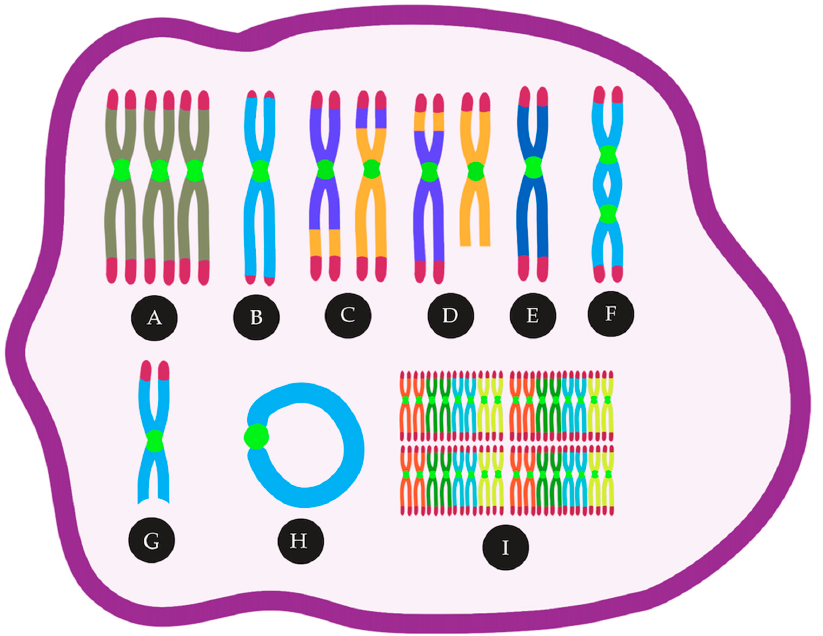
Figure 1. CIN in AML can lead to many cytogenetic abnormalities, such as (A) trisomies, (B) telomere loss, (C) reciprocal translocations, (D) unbalanced translocations, (E) monosomies, (F) Dicentric chromosomes, (G) deletions, (H) ring chromosomes, (I)